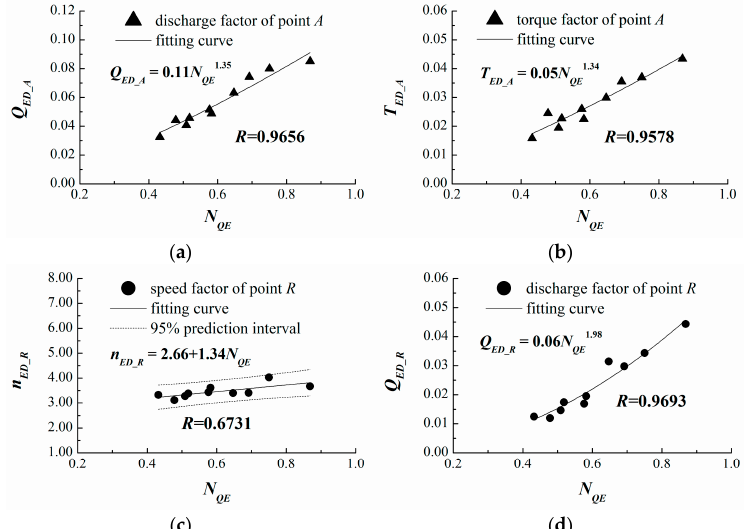
Figure 5. The relationship between N QE and the characteristic parameters of point A and point R :